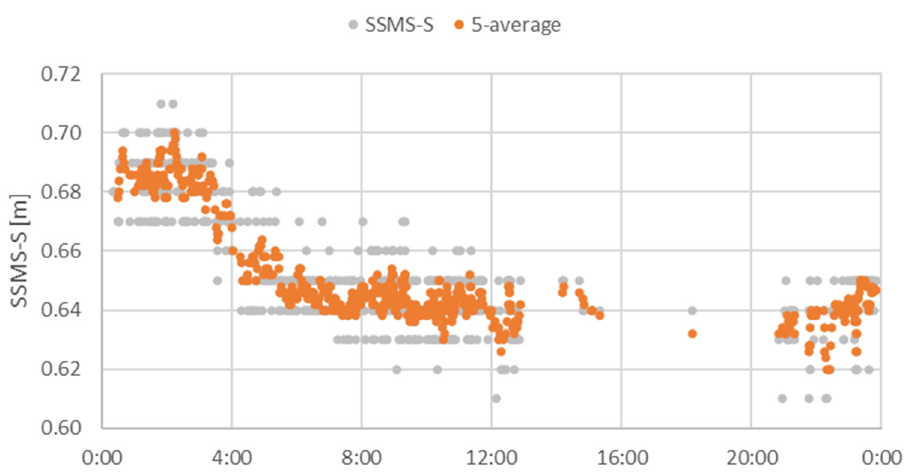
Figure 16. Roof support No. 59 pressure and tip to face distance (moving average of 5 values).